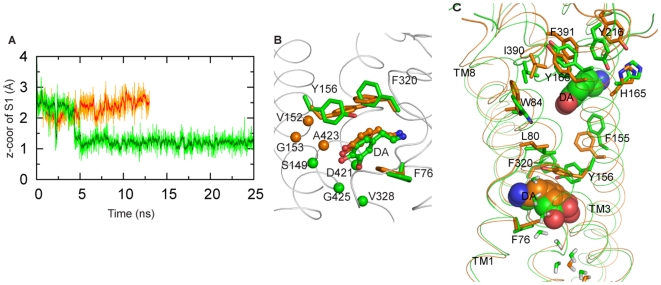
The allosteric effect of S2 on the S1 site.(A) Change in position of the DA substrate in the S1 site during equilibration of the S1,S2-DAT model. The green trace shows that the Z-coordinate of DA (center of mass) decreases by ∼ 1.5 Å (i.e., DA is shifted downward toward the intracellular side), compared to its position in S1-DAT (orange trace). (B) The positional changes of DA, the rotamer changes of F761.42, Y1563.50 and F3206.53, and the changes in the composition of the S1 site in S1-DAT (residues rendered in orange) compared to S1,S2-DAT (in green). Note that in S1,S2-DAT, the substrate interacts more (i.e., a higher percentage of time) with S1493.43, V3286.61, and G4258.63, and establishes a new interaction with D4218.59 (Cα atoms shown as orange spheres) while losing interactions with V1523.46, G1533.47 and A4238.61 (Cα atom shown as green spheres). (C) The residues forming an interaction network involved in conformational transitions between S1-DAT (orange) and S1,S2-DAT (green). Residues I390EL4 and F391EL4 are in contact with DA in the S2 site. Note that changes in W841.50, L801.46, Y1563.50 and F3206.53 are coordinated with I390EL4 and F391EL4 (Table 1).